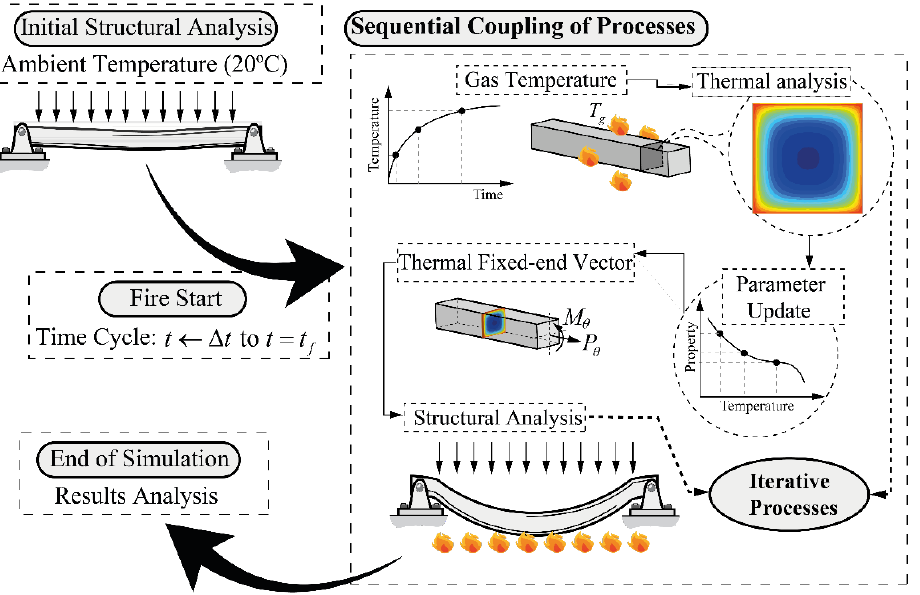
Figure 3. General procedures for solving the thermomechanical problem of structures under fire